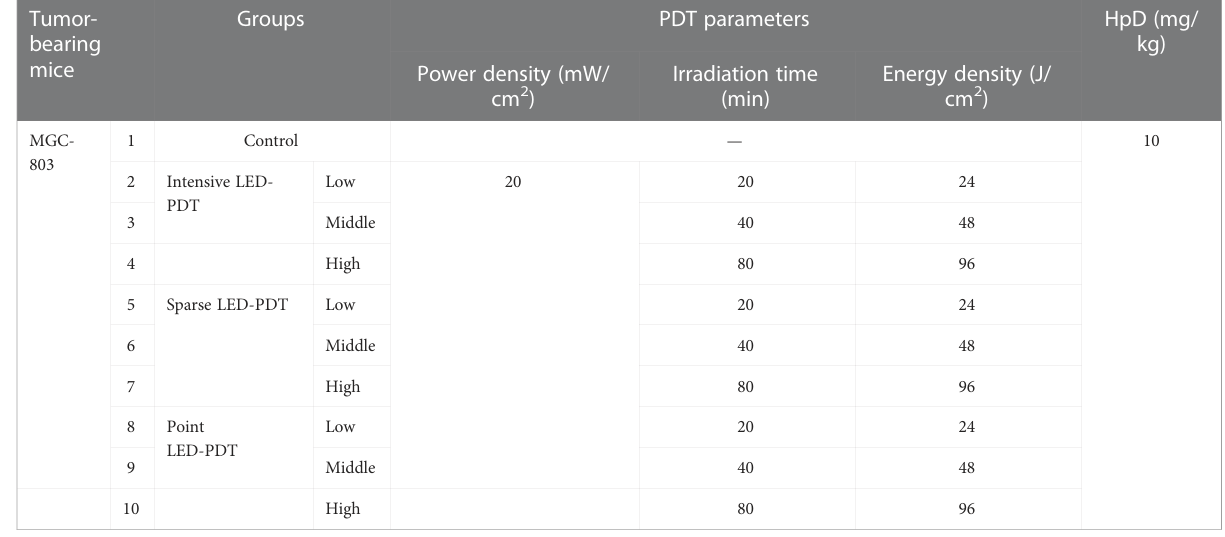
TABLE 1 Groups of tumor-bearing mice and corresponding PDT parameters. Tumor- bearing